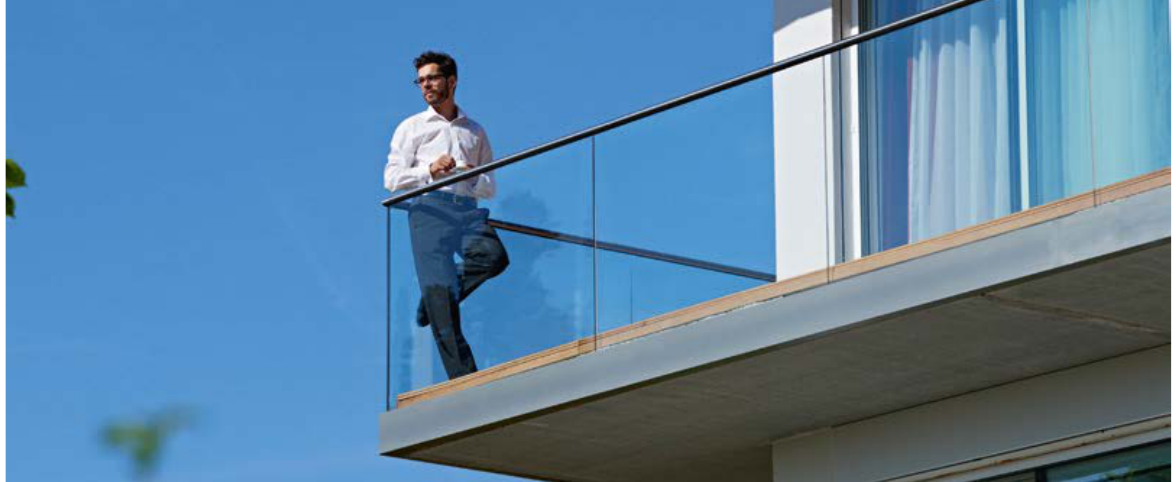
Fig. 1 End-side angled all-glass balustrade with cp-1402 model from Pauli + Sohn